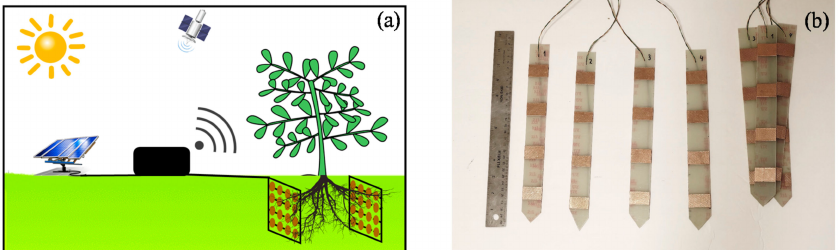
Figure 1. ( a ) Schematic diagram of the solar-powered standalone data acquisition device. ( b ) One